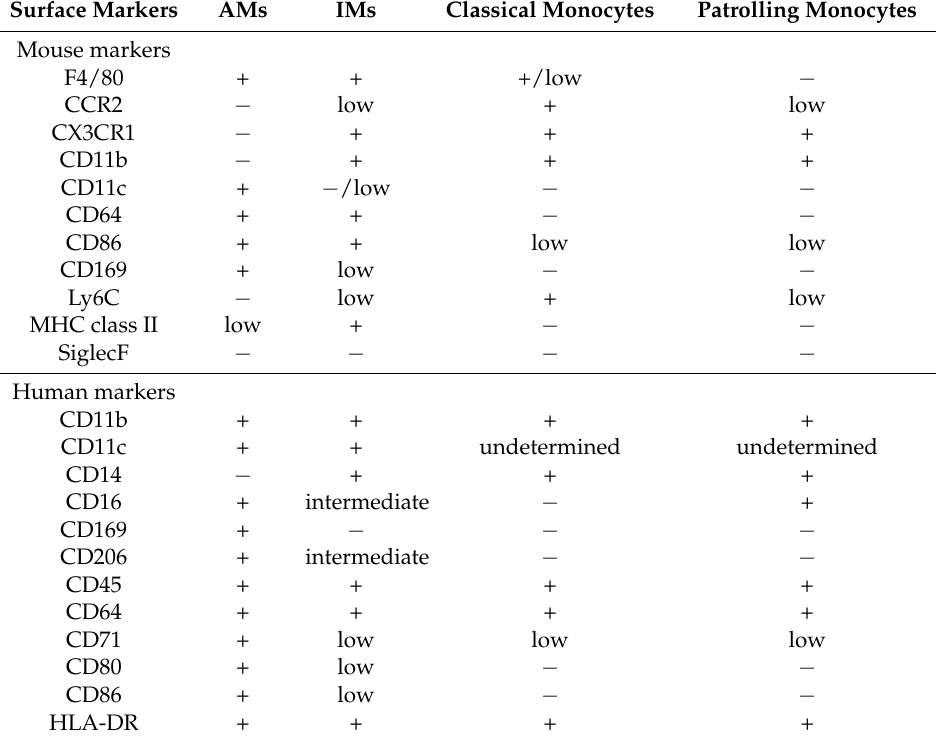
Table 1. Major surface markers of mouse and human lung monocyte/macrophage populations